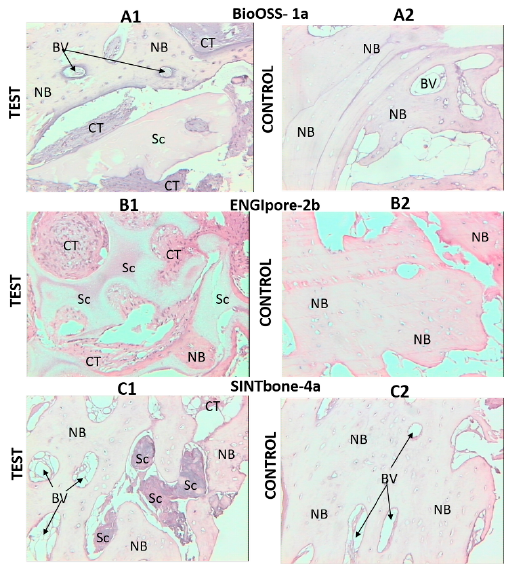
Figure 6. Histology images of specimens test (left side) and control site (right side): ( A1 ) 1a test, entire specimen; ( A2 ) 1a control; ( B1 ) 2b test; ( B2 ) 2b control; ( C1 ) 4a test and ( C2 ) 4a control; Legend: CT = Connective Tissue; Sc = residual Scaffold; NB = New Bone; BV = Blood Vessels.